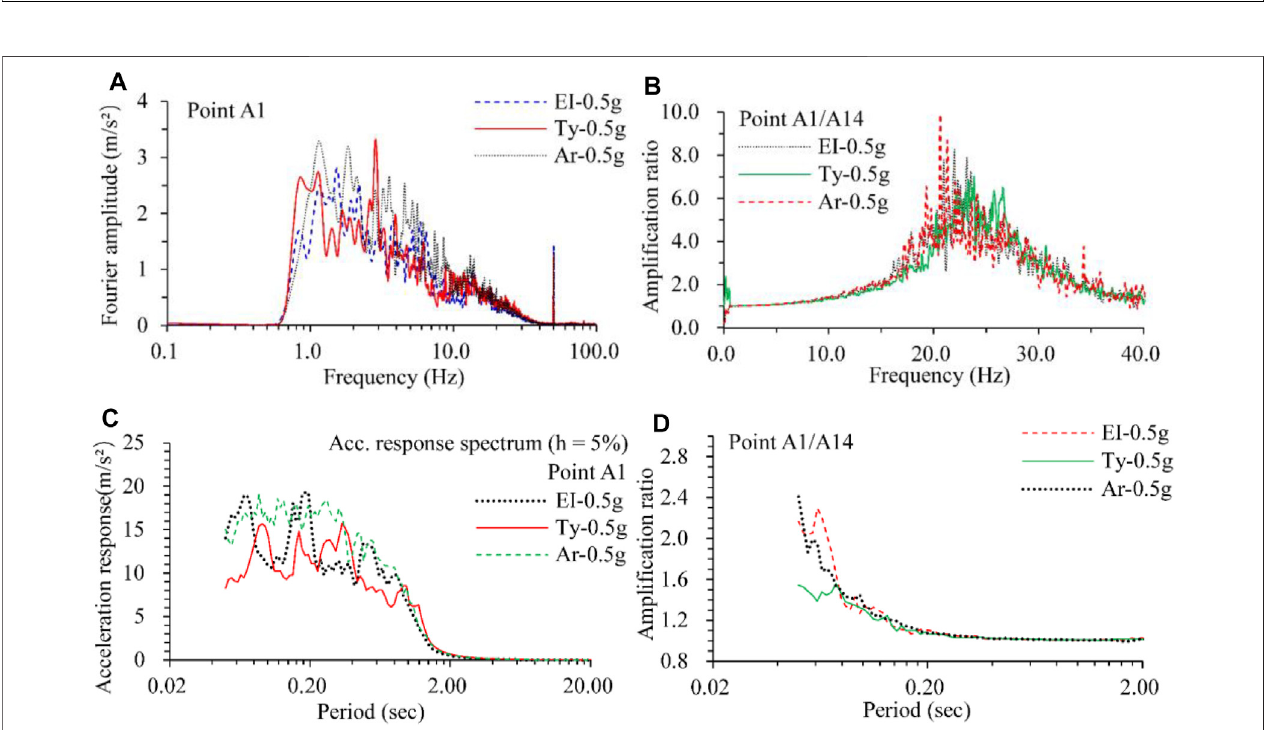
FIGURE 15| Comparison ofFourier spectrum and response spectrum, (A) Fourier spectrum oftime history recorded at point A1, (B) the Fourier spectrum ratio of A1 to A14, (C) response spectrum of the time history recorded at A1, (D) the response spectrum ratio of A1 to A14.